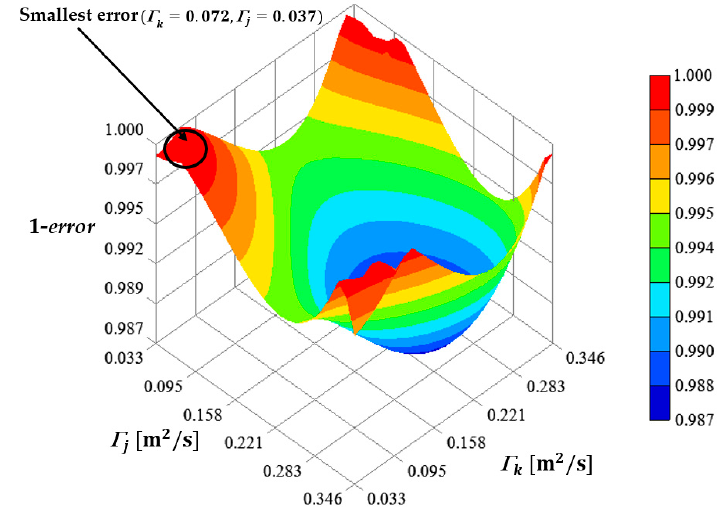
Figure 7. Three-dimensional chart showing the distribution of the value of 1 − error in the model calculation of two rotors in the CO-like layout with a wide searching range from 0.1 Γ SI to 1.1 Γ SI .